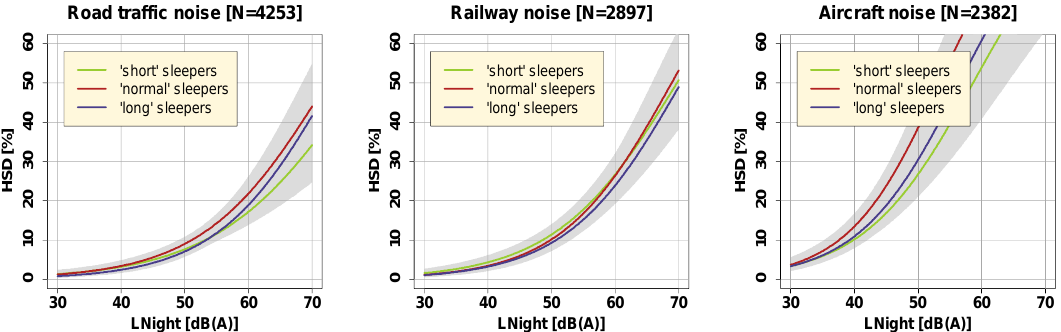
Figure 9. Exposure-response relationships for road traffic (left), railway (middle), and aircraft noise (right), for ‘short’, ‘medium’, and ‘long’ sleepers, including (overlapping) 95% confidence intervals (shaded areas). Curves are based on the adjusted model in the full sample with covariates centered on the mean.